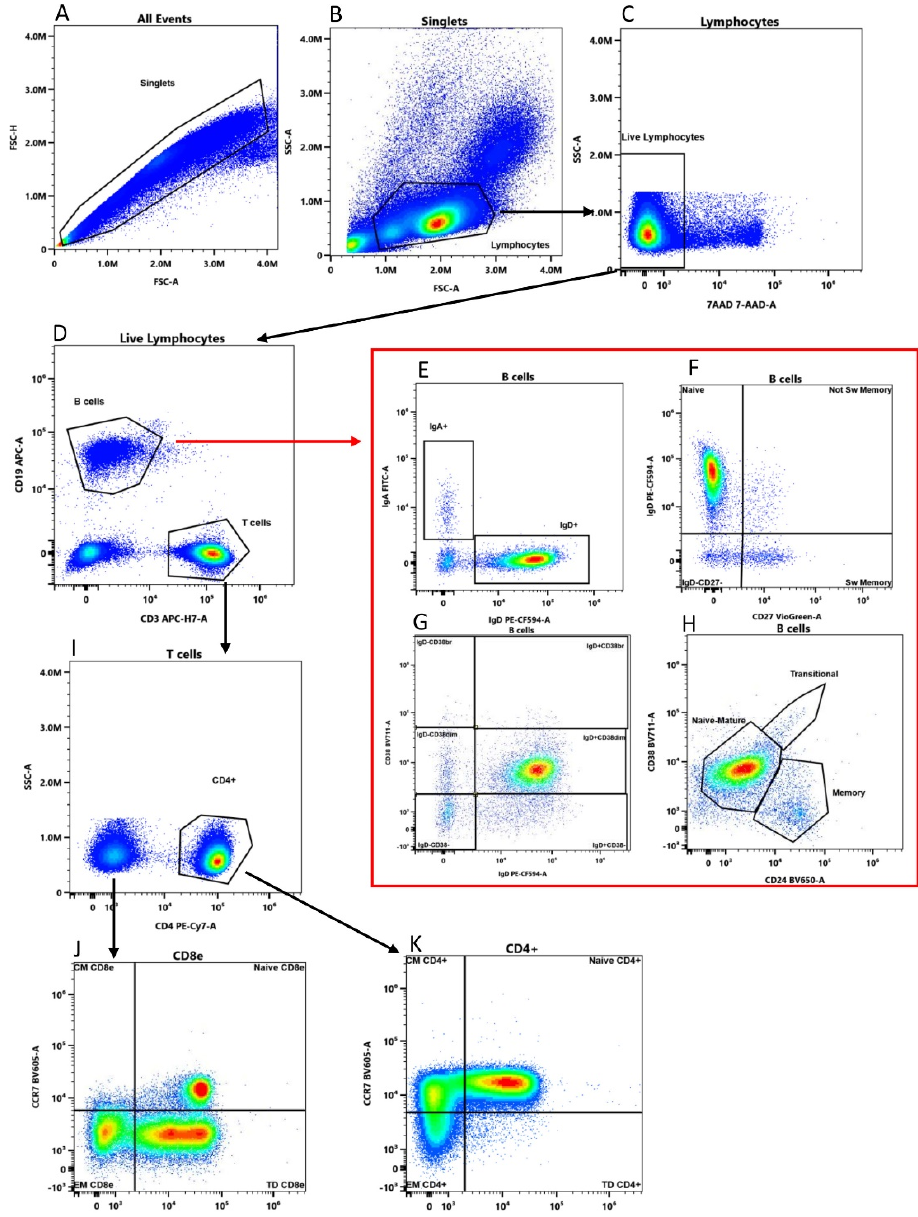
Figure 1. Gating strategy of a representative sample. ( A , B ) Lymphocytes were identified based on morphological parameters. ( C ) 7 ‐ AAD negative single cells were considered viable lymphocytes and ( D ) divided in B (CD19+ CD3 − and T cells (CD19 − CD3+). ( E ) B cells (red frame) were divided in IgD+ and IgA+ B cells; ( F ) switched memory (CD27+ IgD − ), un ‐ switched memory (CD27+ IgD+), naïve (CD27 − IgD+) and CD27 − IgD − B cells; ( G ) IgD+ CD38 − , IgD+ CD38dim, IgD+ CD38br, IgD − CD38br, IgD − CD38dim, and IgD − CD38 − subsets. ( H ) CD24 and CD38 define transitional (CD24+ CD38hi), memory (CD24+ CD38 − /dim) and naïve ‐ mature (CD24 − CD38 − /dim) subsets. ( I ) T cells not expressing CD4 were considered CD8 ‐ enriched cells (CD8e). ( J ) CD8e and ( K ) CD4+ T cells were divided in Central Memory (CM, CD45RA − CCR7+), Naïve (CD45RA+ CCR7+), Effector Memory (EM, CD45RA − CCR7 − ) and Terminally Differentiated (TD, CD45RA+ CCR7 − ).